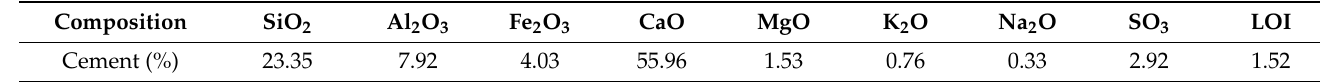
Table 1. Chemical composition of cement.